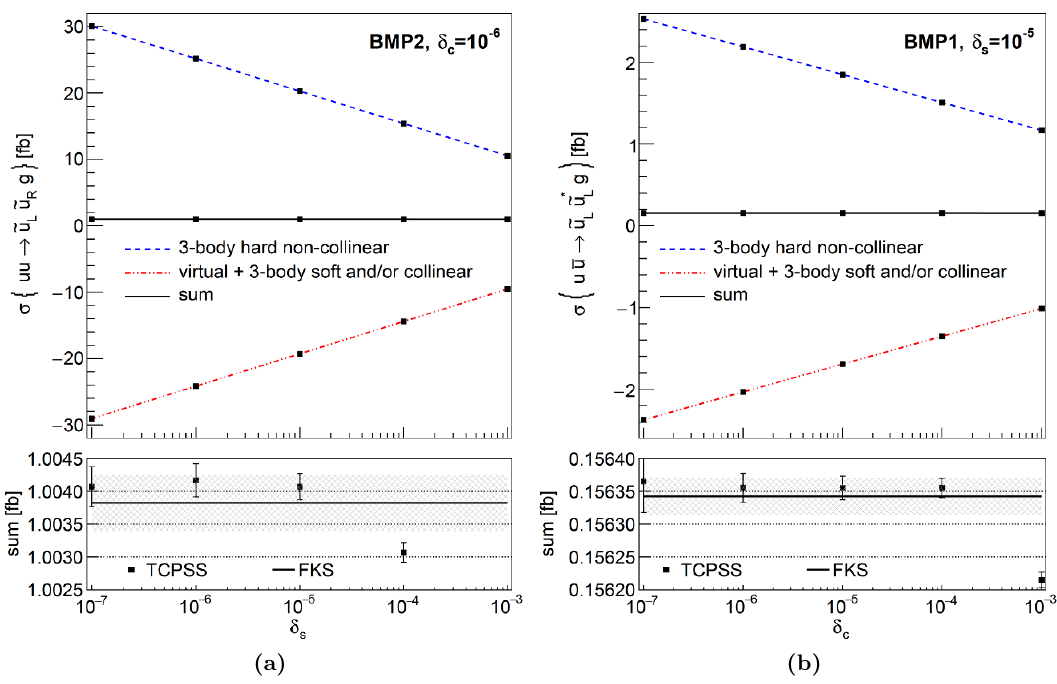
Figure 5. Proof of cut parameter cancellation for the two selected subprocesses uu ! ~ u L ~ u R g